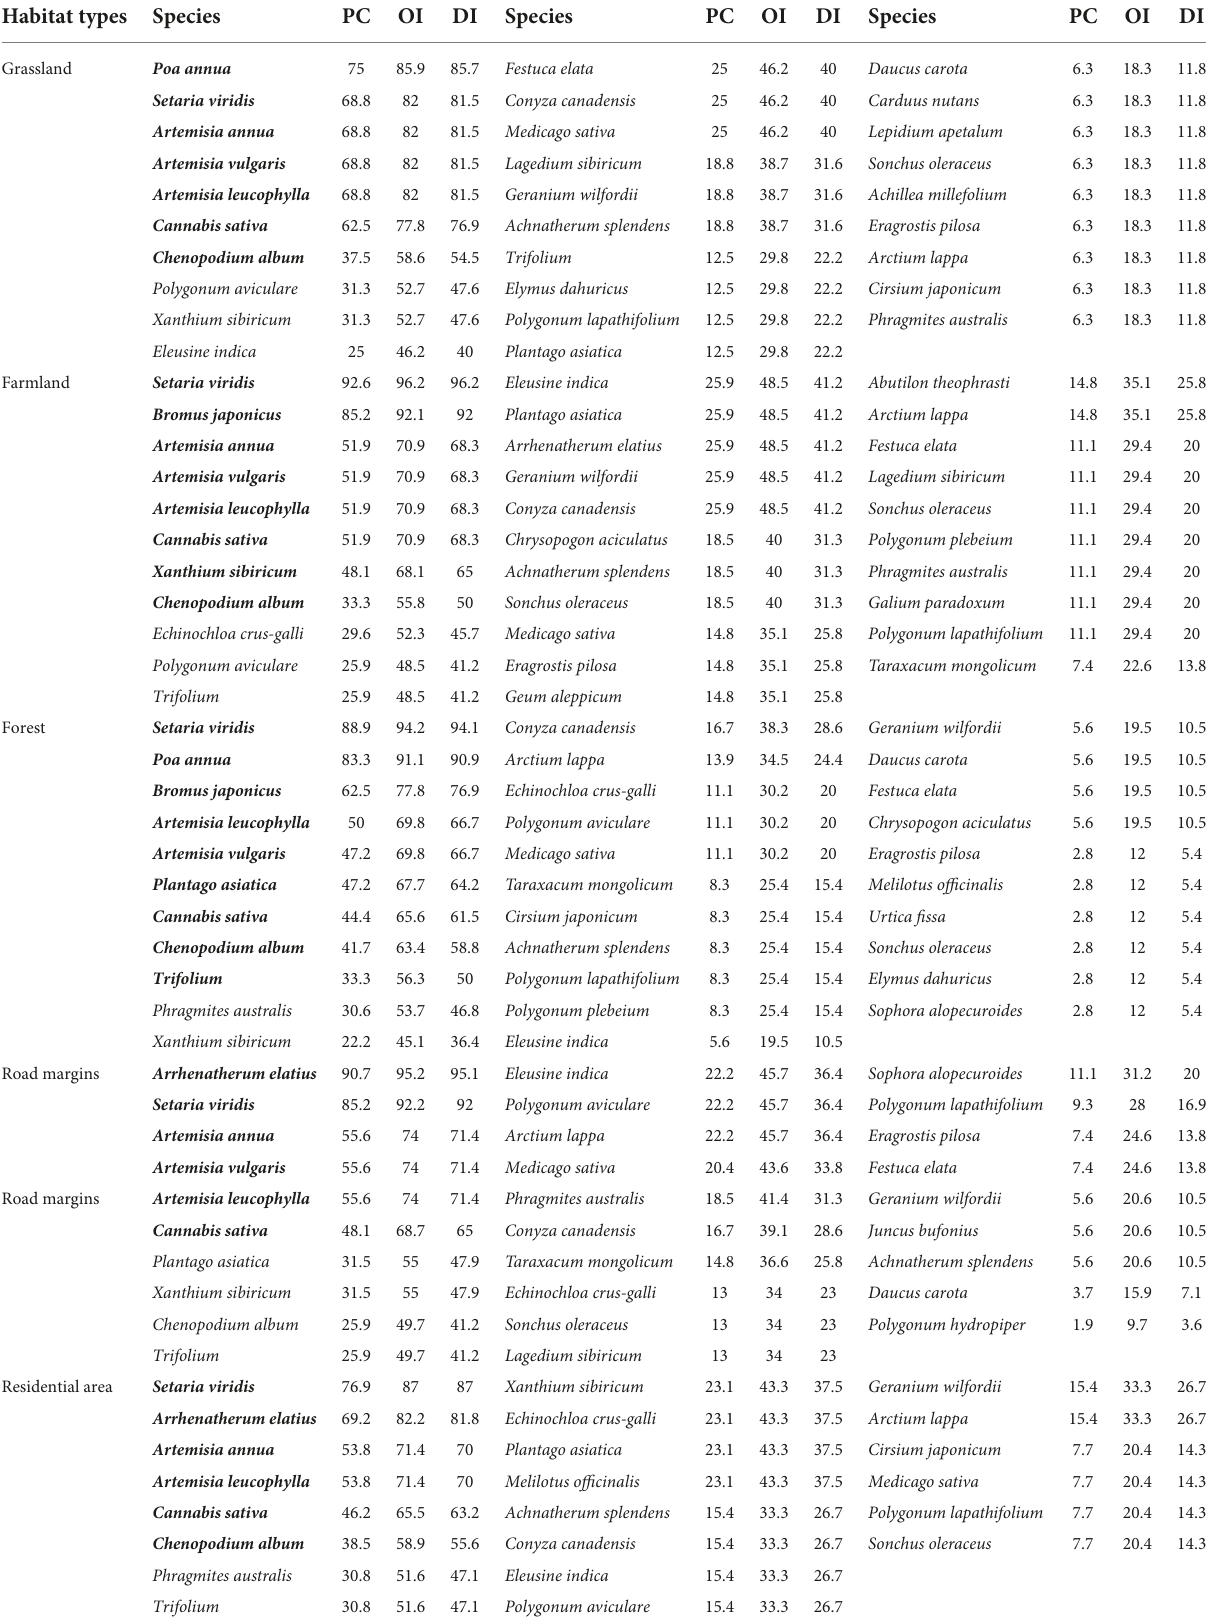
TABLE 3 Common percentages of native species and Ambrosia artemisiifolia invasive habitat communities in the Yili Valley. Habitat types Grassland